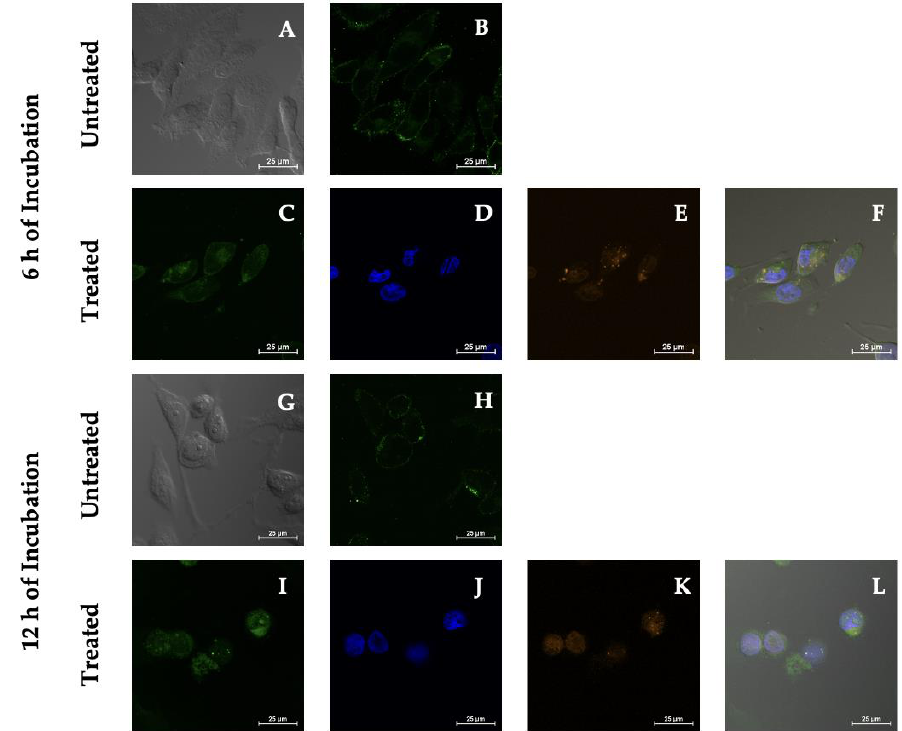
Figure 5. PSI-LHCI internalization in MDA-MB-231 cells by confocal microscopy studies. Phase- contrast ( A , G ) and green plasma membrane ( B , H ) of untreated MDA-MB-231 cells after 6 and 12 h of incubation. Treated MDA-MB-231 cells were incubated for 6 and 12 h with PSI-LHCI ( E , K ) orange in color, DAPI ( D , J ) blue in color, and plasma membrane ( C , I ) green in color. Merged pictures are presented in ( F , L ). All images were taken at 60 × magnification. Scale bars, 25 µ